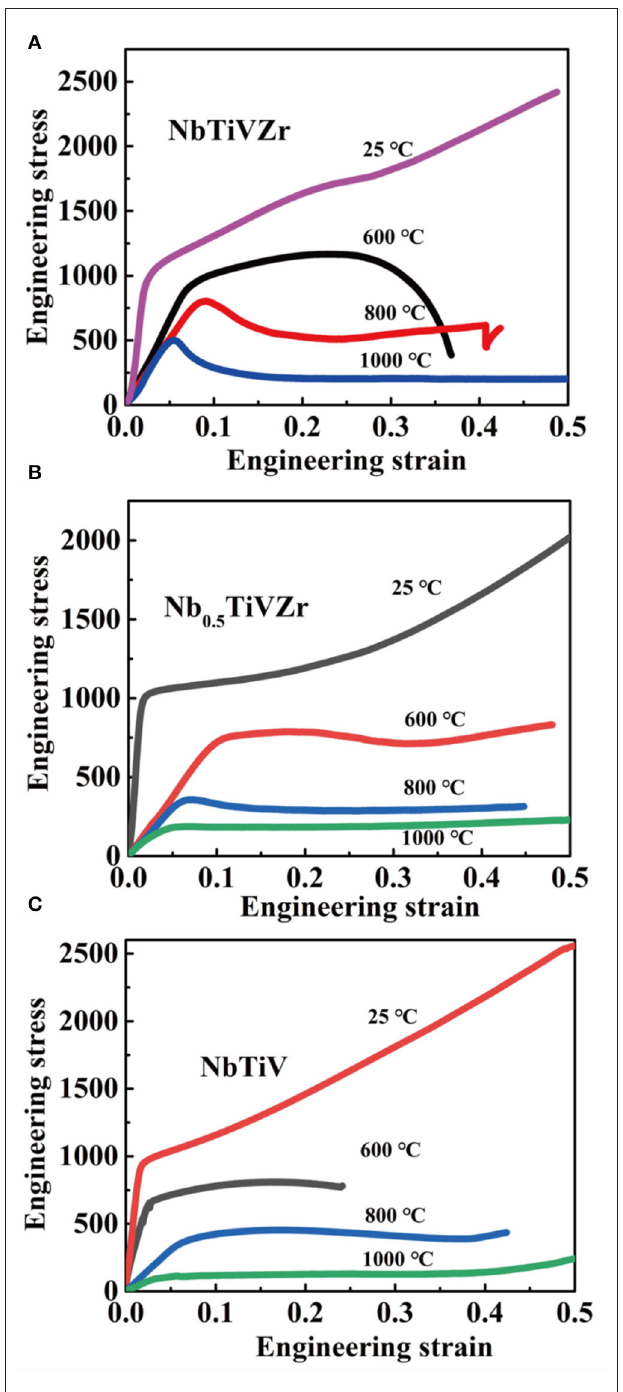
FIGURE 3 | Engineering stress–strain curves of (A) NbTiVZr, (B) Nb0.5TiVZr, and (C) NbTiV alloys compressed at the different temperatures.